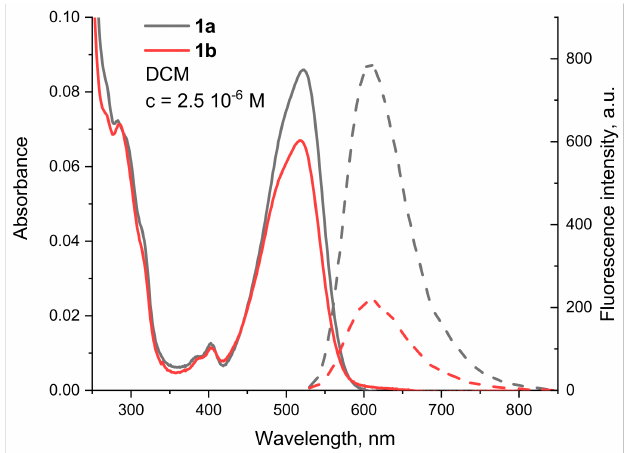
Figure 5. Absorption (solid line) and fluorescence (dashed line) spectra of 1a (black) and 1b (red) in DCM, c = 2.5 10 − 6